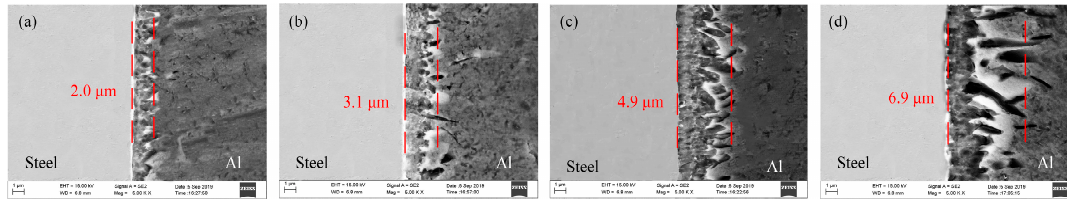
Figure 11. Microstructure of the IMCs layer with different laser power: ( a ) 1.9 kW; ( b ) 2.0 kW; ( c ) 2.1 kW; ( d ) 2.2 kW.